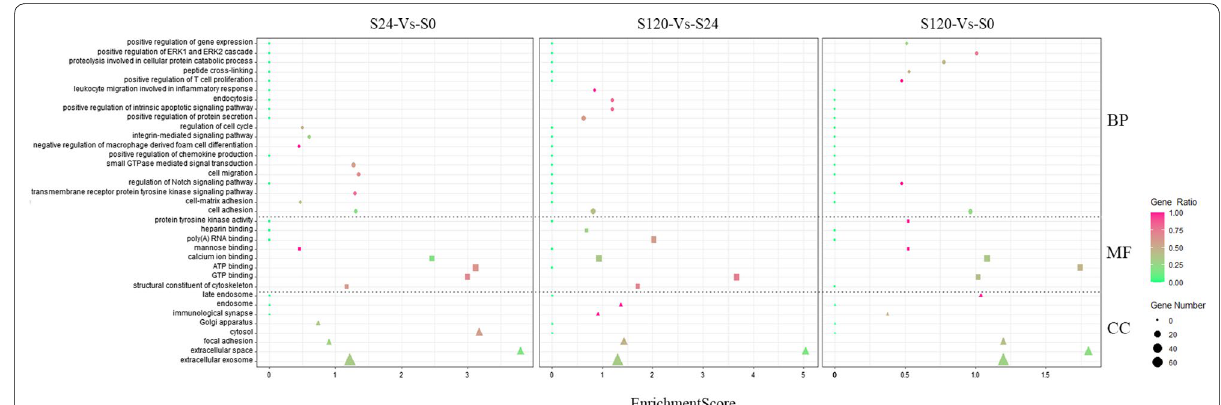
Fig. 2 Gene ontology annotation analysis. Cellular component (CC), molecular function (MF) and biological process (BP); GO term is the X-axis and the numbers of enrichment are the Y-axis. The Q value < 0.05 were defined